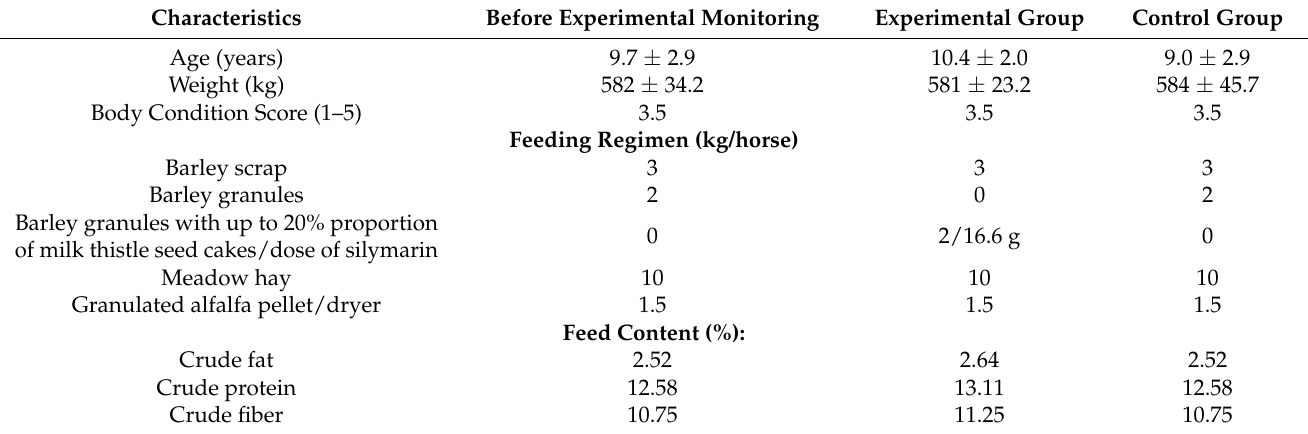
Table 1. The characteristics of the horses in the experimental